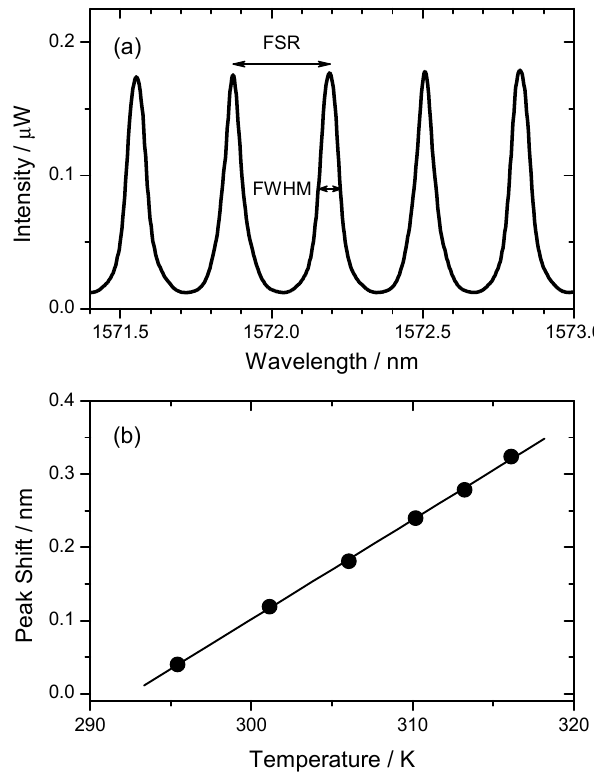
Fig. 3 Fig. 3. (a) Free spectral range (FSR=0.317 ± 0.002nm) and full- width at half maximum (FWHM=0.072 ± 0.002nm) of FFPI; (b) Spectral shift of the transmission wavelength by temperature. Tem- perature coefficient=13.58 ±